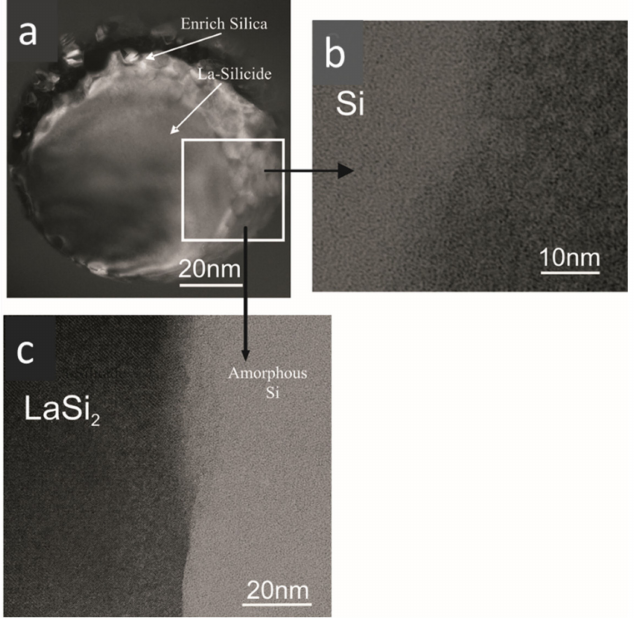
Figure 8. Transmission electron micrographs showing ( a ) silicide particle and ( b , c ) enlarged areas of Si and La-silicide, respectively